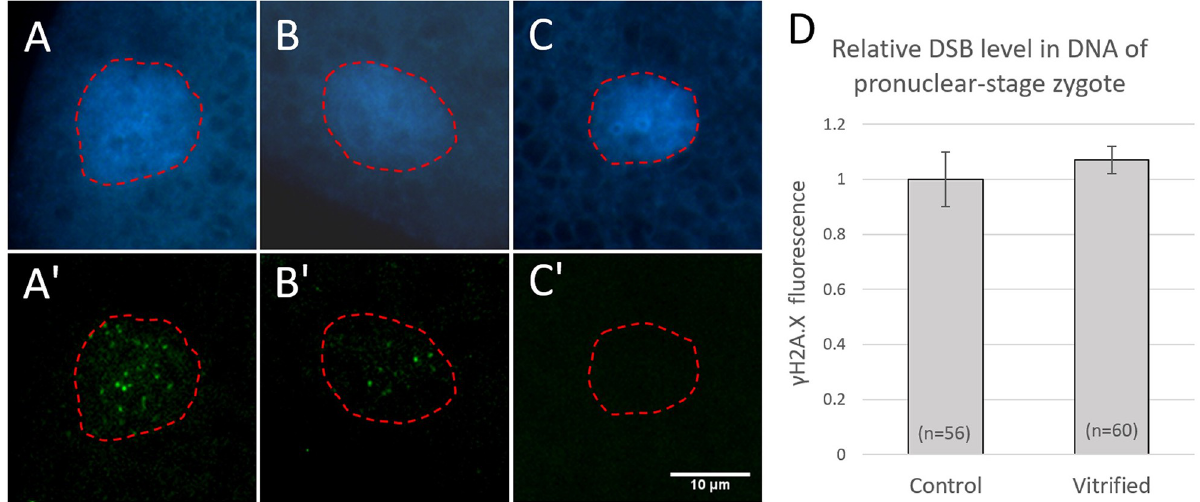
Fig 2. Fluorescent images of DNA (blue, A-C) and the DSB marker γ H2AX (green, A’-C’) in pronuclei of zygotes 8 h after IVF and relative DSB levels (D) without and after vitrification and warming. A-A’: a representative pronucleus in a zygote without vitrification; B-B’: a representative pronucleus in a zygote after vitrification and warming; C-C’: a representative pronucleus in a zygote processed without anti- γ H2AX (negative control). γ H2AX measurement area is highlighted with red dashed line. The scale bare represents 10 μ m. Data are shown as mean ± SEM. Significant difference was not observed in DSB levels between the groups (P � 0.05). The experiment was replicated five times. Total number of zygotes in each group are given in parentheses.